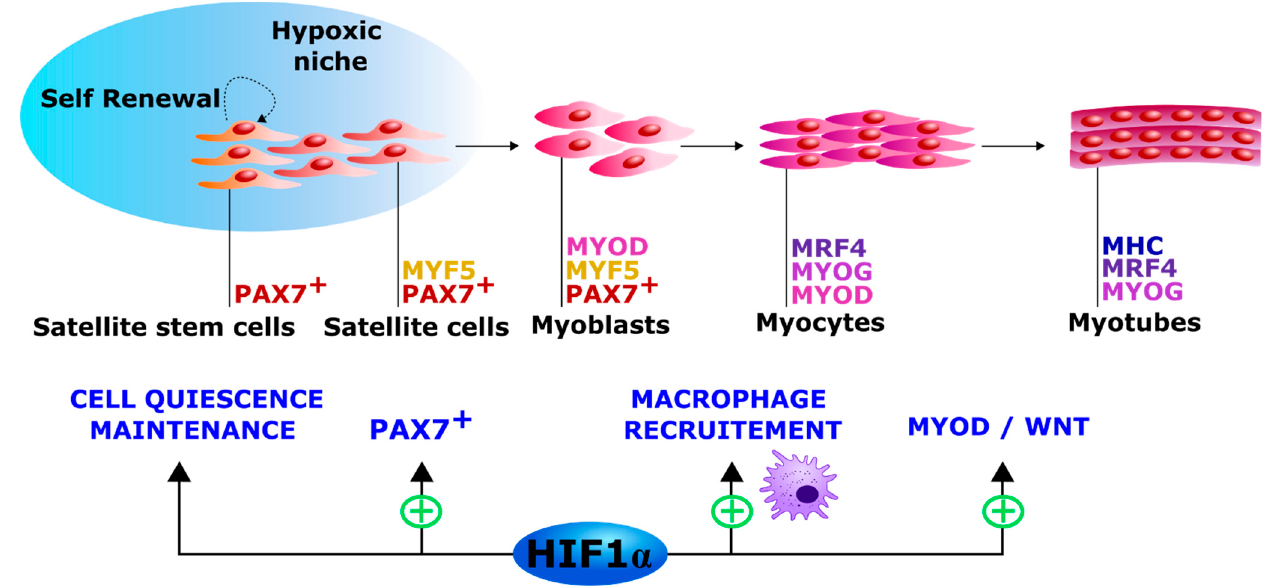
Figure 3. Myogenic differentiation. SCs are myogenic progenitors and are localized in hypoxic niches near the muscle basal membrane. Following muscle injury, quiescent SCs ( PAX7+ and MYF5+/ − ) are activated and differentiate into myoblasts ( PAX7+ , MYF5+ , and MYOD+ ). After their proliferation cycle, myoblasts differentiate into myocytes ( PAX7 − , MYOD+ , MYOG+ , and MRF4+ ). Finally, myocytes fuse together to form multinucleated myotubes ( MYOG+ , MRF4+ , and MHC+ ). The satellite stem cell subpopulation ( PAX7+ and MYF5 − ) can proceed to self-renewal to replenish the SC pool. HIF-1 α pathway activation was found critical to maintain SC quiescence [99]. It was associated to an enhanced myogenic factor activation, an increased number of PAX7+ cells, a more rapid macrophage recruitment after a myotrauma [100] and could promote myogenesis by increasing Myod expression through the WNT pathway [101].